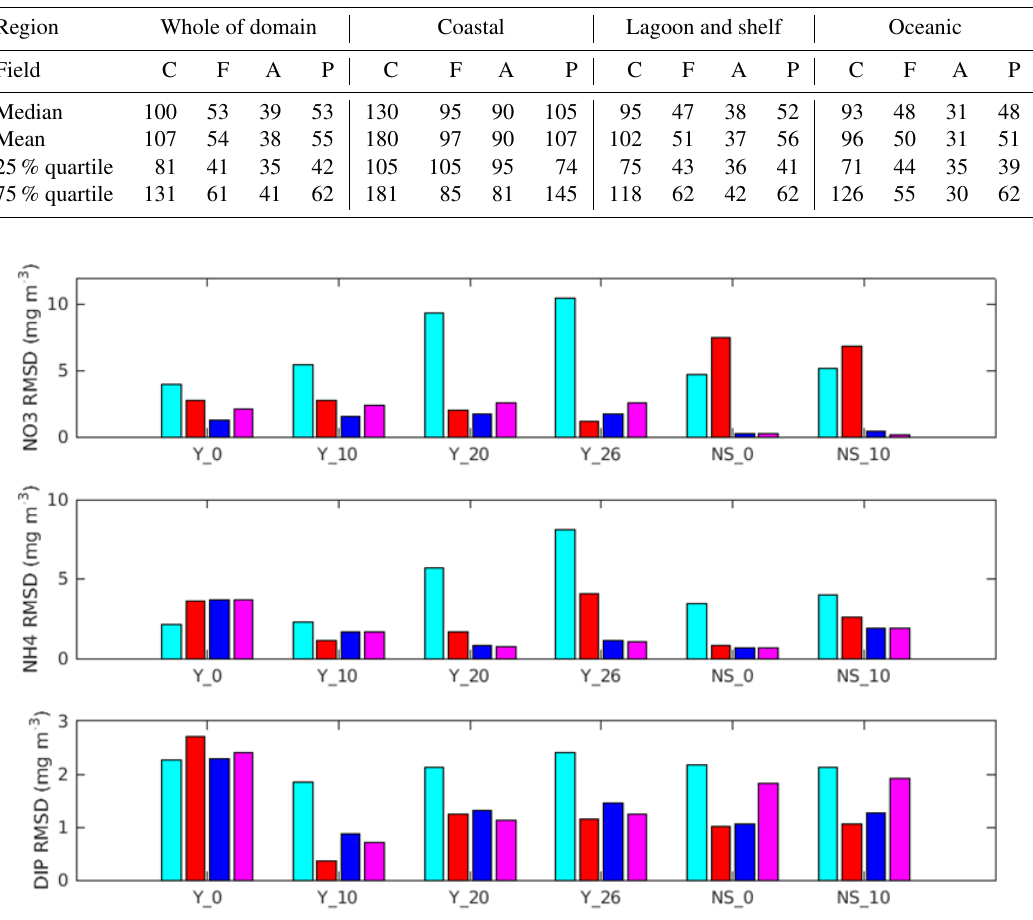
Table 3. Forecast percentage (%) errors for OC3M by region (inshore, lagoon, offshore) for the control (C) and EXP4 forecast (F), analysis (A) and persistence (P) fields.